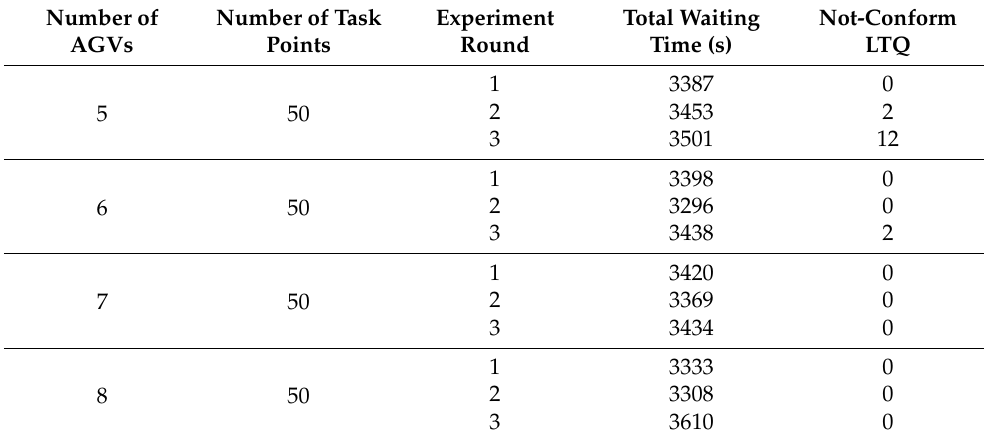
Table 11. The experimental results of different number of AGVs at 50 task points. Number of Number of Task Experiment AGVs Points